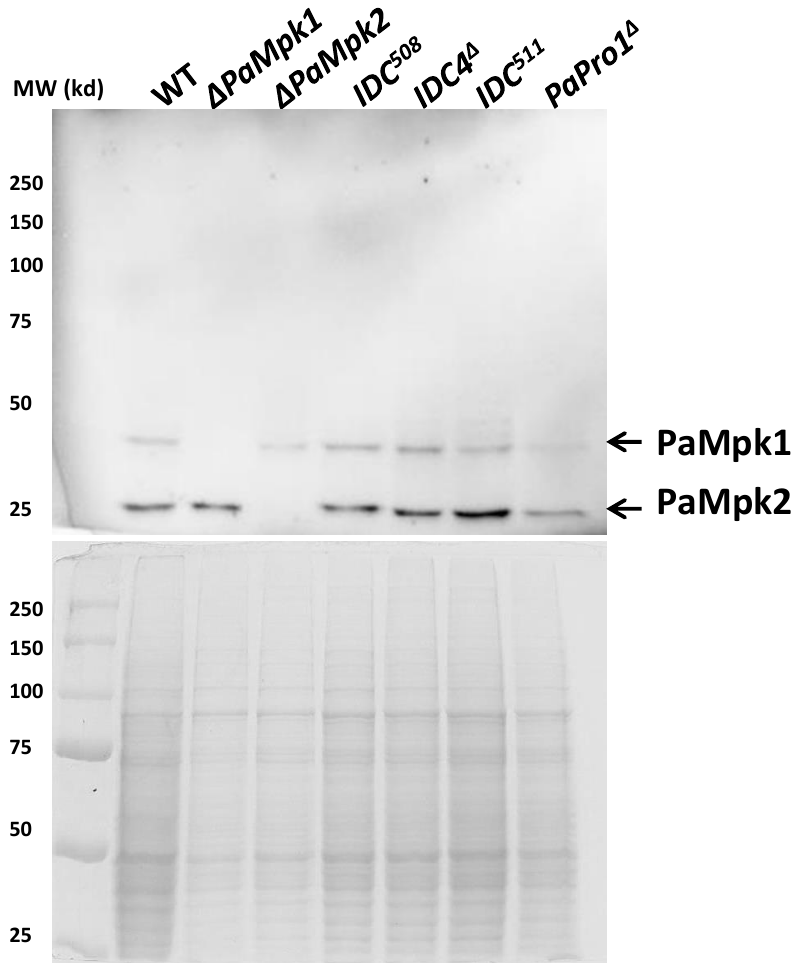
Figure 3. Phosphorylation of PaMpk1 and PaMpk2 is not altered in the PaPro1 and IDC4 mutants. Proteins were extracted from 48-h-old mycelia, separated on a 12% acrylamide gel and probed with an antiphospho-MAPK antibody (Top). Comassie blue-stained gel of the same extracts as loading control is at the bottom. Extracts from ∆ PaMpk1 and ∆ PaMpk2 mutants were loaded as controls. No difference in the amount of phosphorylation is detected for PaMpk1 and PaMpk2